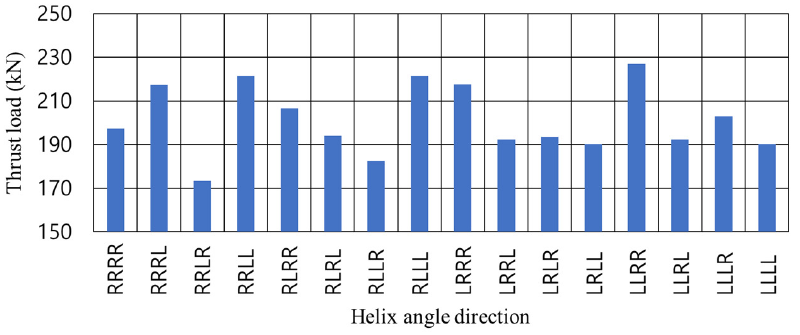
Figure 7. Total maximum thrust loads of the entire combinations of helix angle directions.